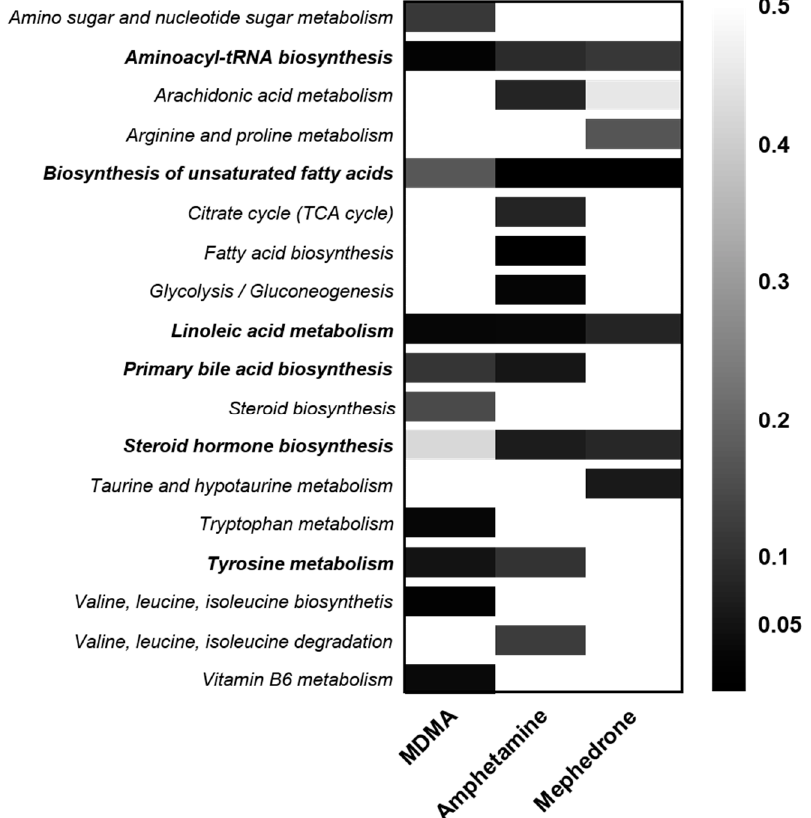
Figure 6. Heat map of the combined (mummichog and gene set enrichment analysis (GSEA)) p -value for all pathways identified as significantly altered in a time-dependent manner (before vs. after drug intake) by MDMA, amphetamine and mephedrone. High significance for a pathway in colored black (0), descendent significance is indicated in lighter colors. Pathways significantly affected by at least two drugs are written in bold.